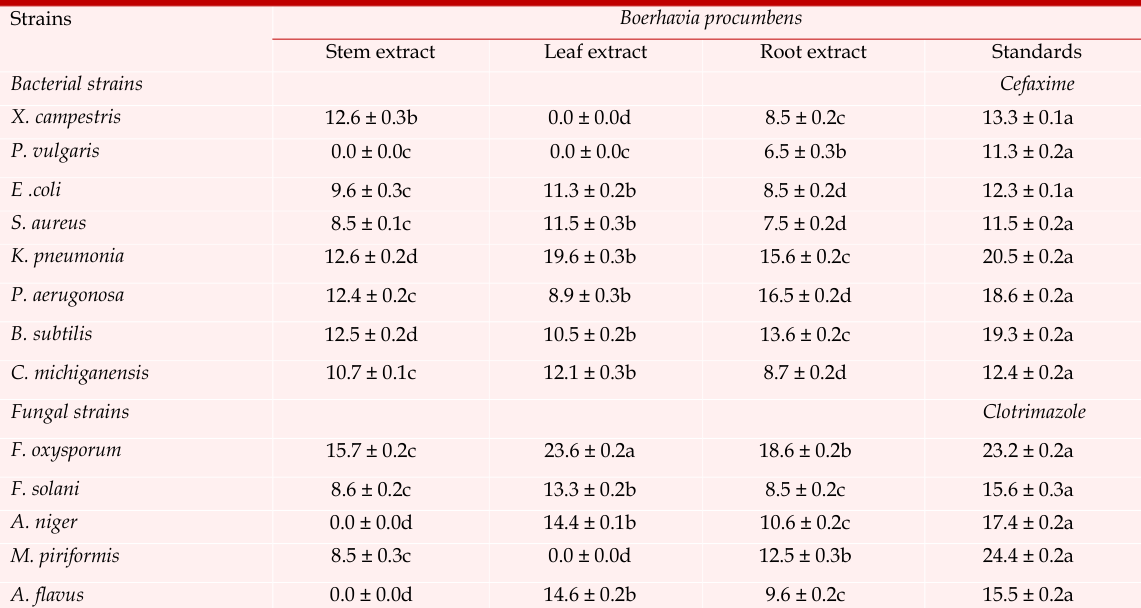
Zone of inhibitory activity (mm) of stem, leaf and root extracts of B. procumbens against bacterial and fungal strains